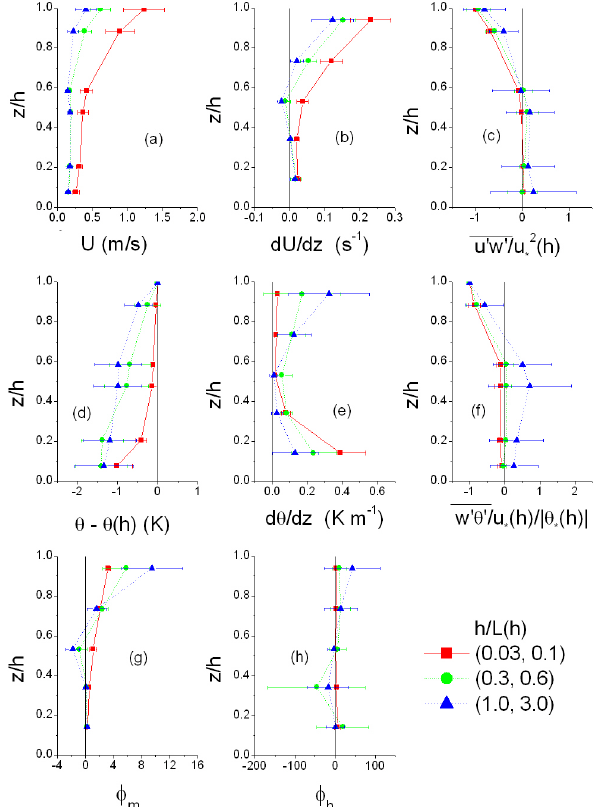
Fig. 2. Vertical profiles of (a) horizontal wind speed, (b) verti- cal gradient of horizontal wind speed, (c) covariance of horizontal and vertical velocities ( u 0 w 0 ) normalized by friction velocity ( u ∗ ) at tree top, (d) difference of potential temperature ( θ ) from that at tree top, (e) vertical gradient of θ , (f) covariance of w and θ nor- malized by u ∗ and temperature scale ( θ ∗ ) at tree top, (g) similarity function of wind ( φ m ) , and (h) similarity function of temperature ( φ h ) , in weakly, moderately and strongly stable conditions with the atmospheric stability indicated with h/L(h) at tree